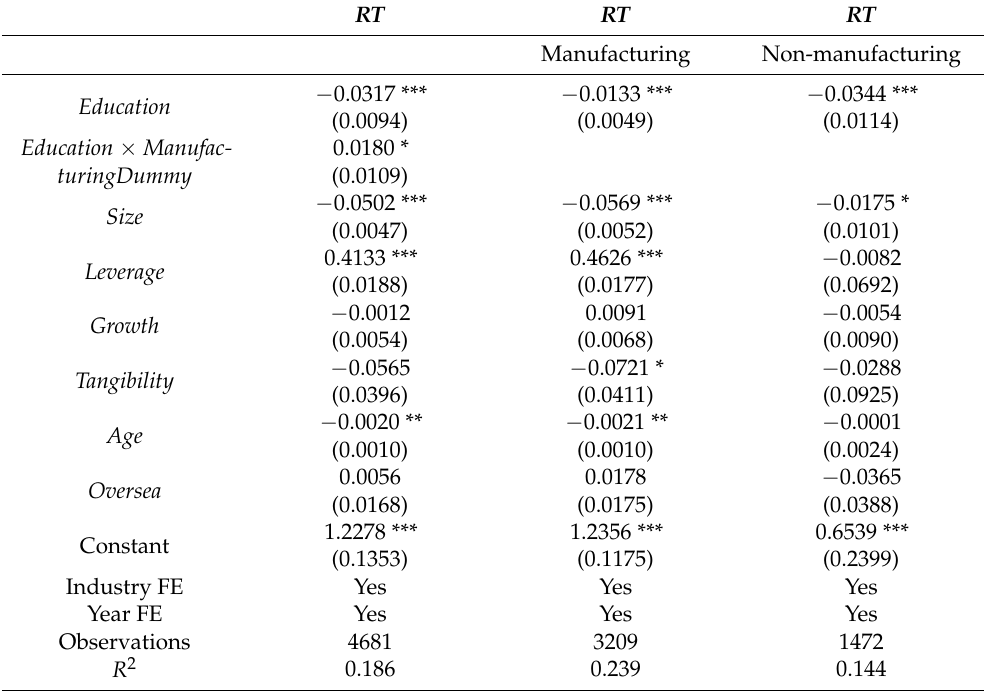
Table 7. Manufacturing vs. non-manufacturing